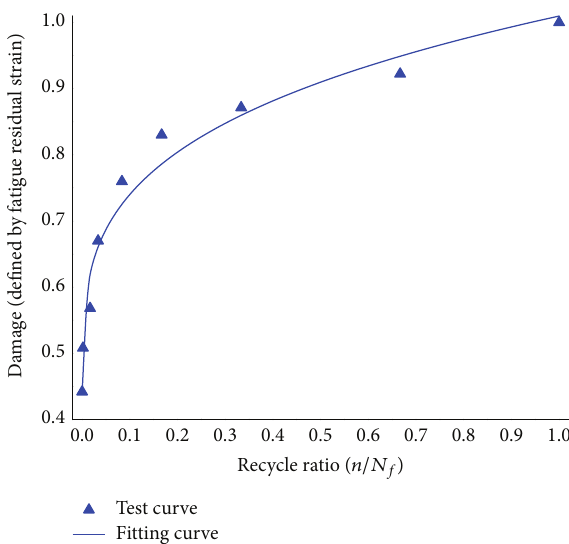
Figure 11: Damage result of JL-4 based on fatigue residual